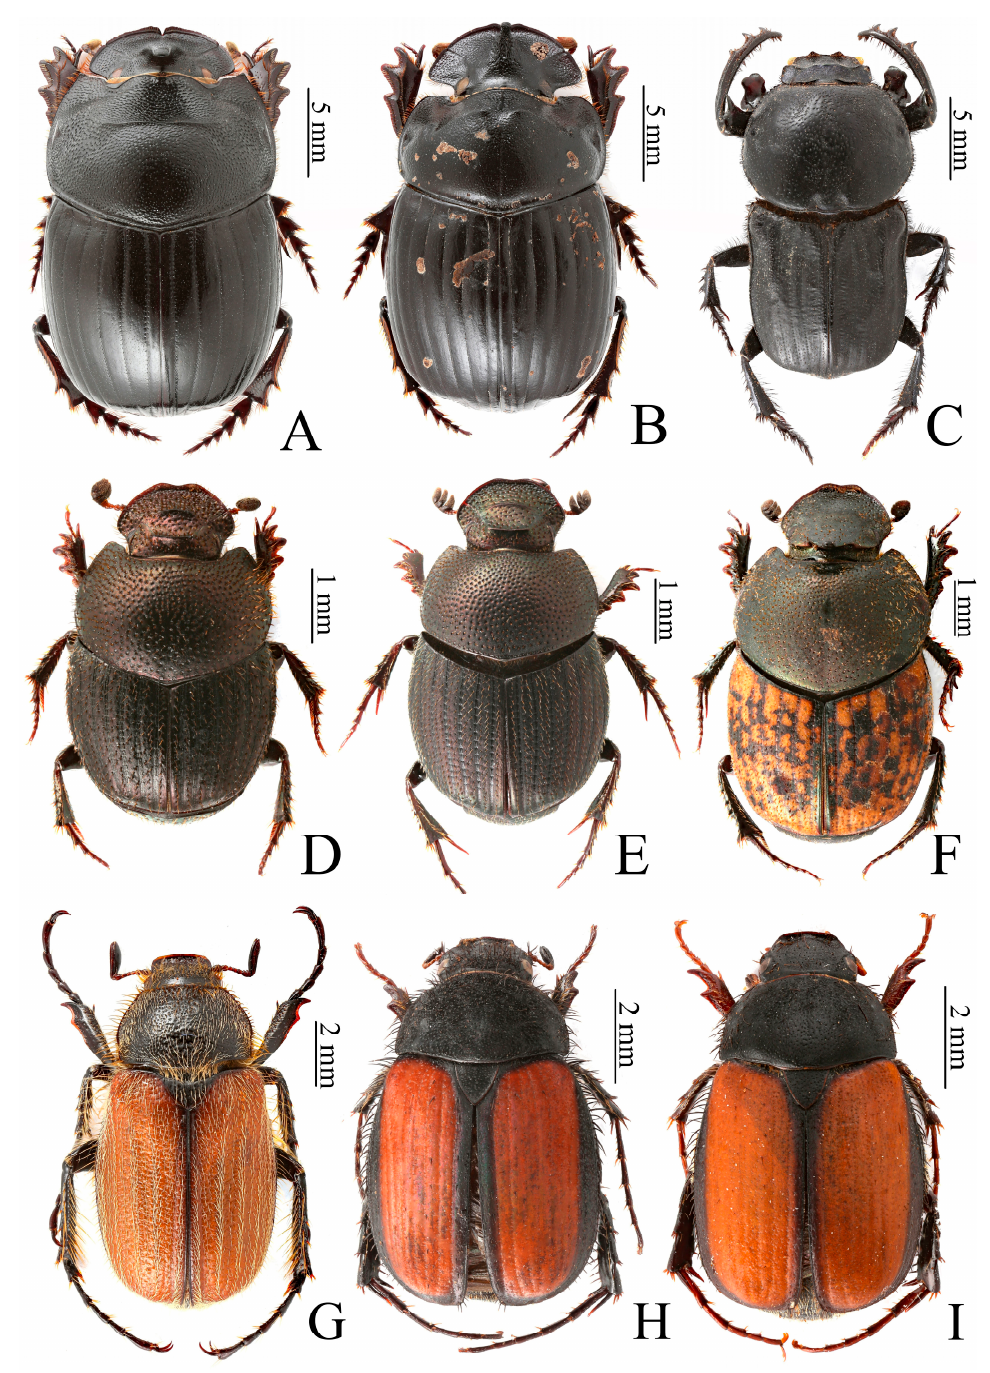
Figure 6. Rare and new species for the fauna of Serbia recorded in the course of this study: ( A )—*Copris hispanus cavolinii (V. Petagna, 1792), ( B )—*C. umbilicatus Abeille de Perrin, 1901, ( C )—*Cheironitis furcifer (P. Rossi, 1792), ( D )—Onthophagus angorensis Petrovitz, 1963, ( E )—*O. dellacasai Pittino & Mariani, 1981, ( F )—*O. similis (Scriba, 1790), ( G )—*Holochelus costulatus (Frivaldszky, 1835), ( H )—*Omaloplia corcyrae (Baraud, 1965), ( I )—O. illyrica (Baraud, 1965) (Photos: Ł ukasz Minkina). Copris lunaris (Linnaeus, 1758) Localities. Vrdnik at Irig, 8–9 June 2022, 3 exx. [AB, ST]; Krušedol Selo at Irig, 9 June 2022, 2 exx. [AB, ST]; Šušara at Vršac, 23–24 May 2022, 1 ex. [ST]; Deliblato at Kovin, 24 May 2022, 2 exx. [AB, ST]; Dubovac at Kovin, 25 May 2022, 1 ex. [ST]; Tekija at Kladovo, 26 May 2022, 1 ex. [AB]; Jablanica at Č ajetina, 23–28 July 2019, 1 ex. [DM]; Ljubiš at